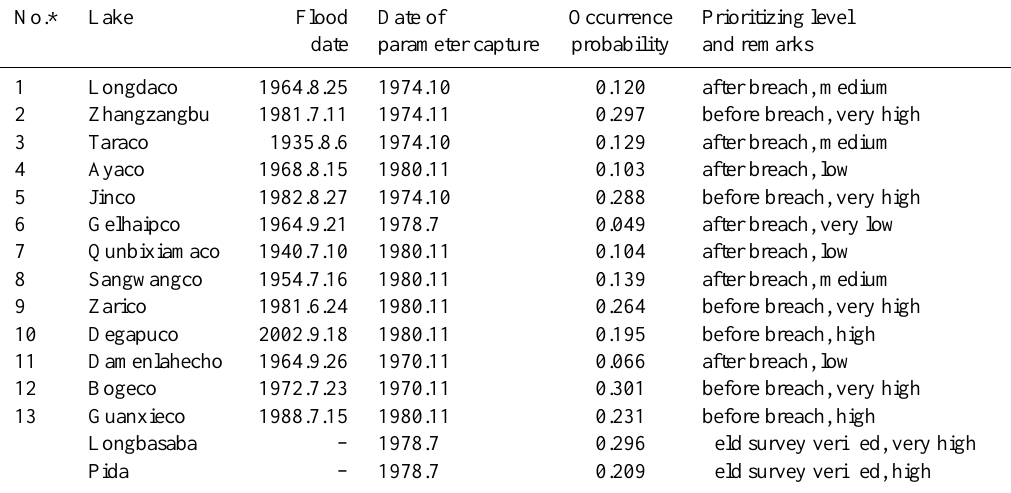
Table 7. Probabilities for example moraine-dammed lakes showing the reliability of the event-tree model. No.*